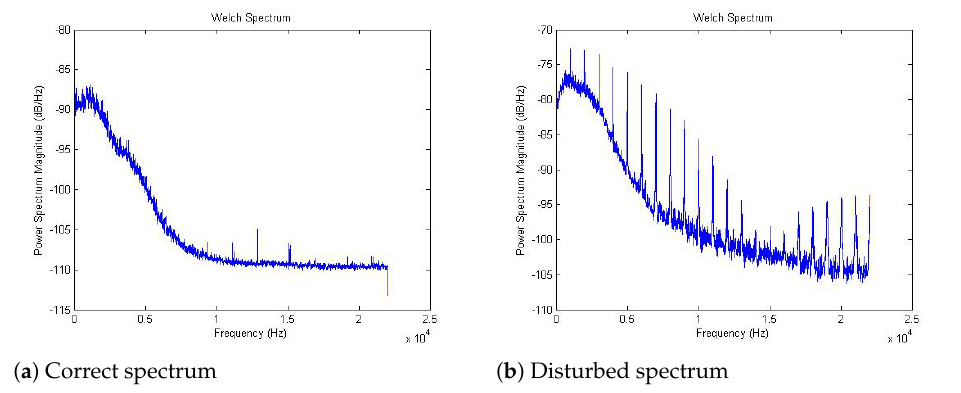
Figure 7. Comparison of signal spectra.